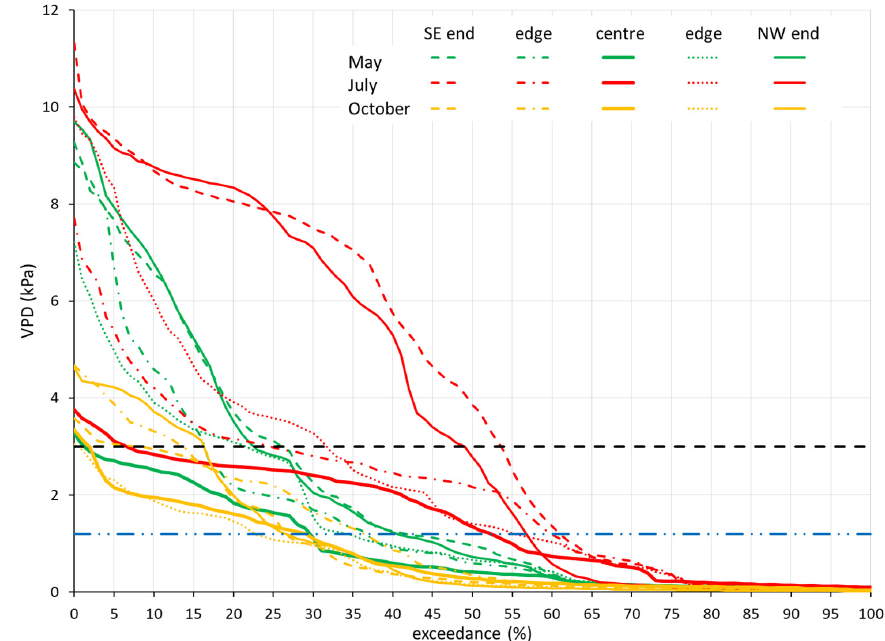
Figure 3. VPD duration curves for the SE–NW transect from three 24-h measurement periods. Blue dashed line indicates the 1.2 kPa physiological threshold; black dashed line indicates 3.0 kPa threshold, above which the exceedance rates significantly diversified.